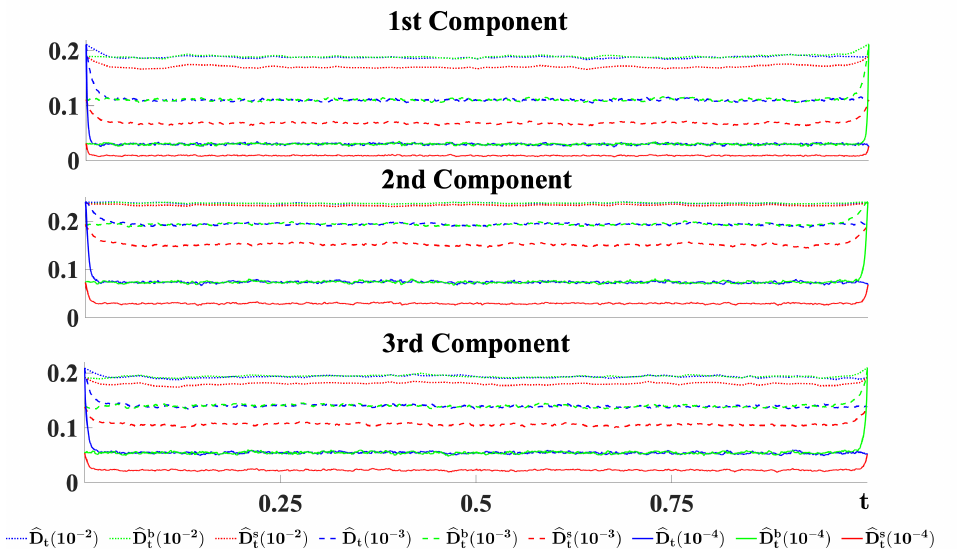
mates (forward-time filtering (cid:98) D t , backward-time-filtering (cid:98) D b ones (cid:98) D s ) calculated with various time discretization steps δ = 10 − 2 , 10 − 3 , 10 − 4 . One can t see the expected convergence.